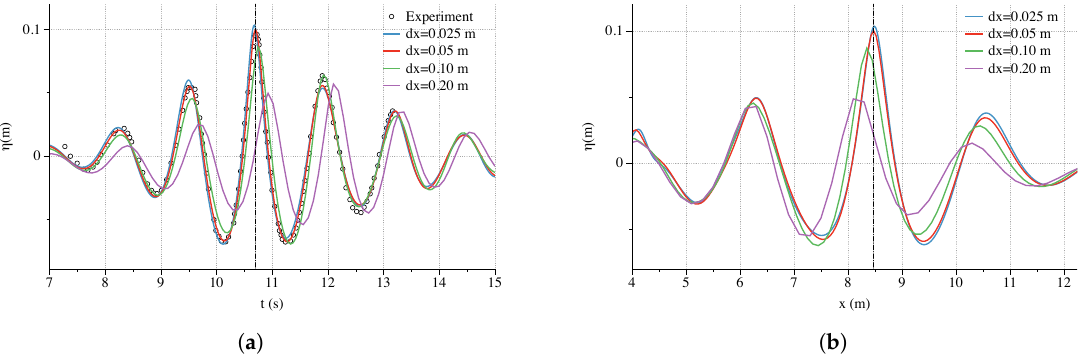
Figure 10. Grid convergence study in the x-direction for the case NING3, where four grid sizes are tested dx = 0.025, 0.05, 0.1 and 0.2 m. Ten vertical cells are used in the study. ( a ) The time series at the focusing location x = 8.475 m, ( b ) the spatial wave profiles at the focusing location t = 10.7 s. Experiment Nz=40 Nz=20